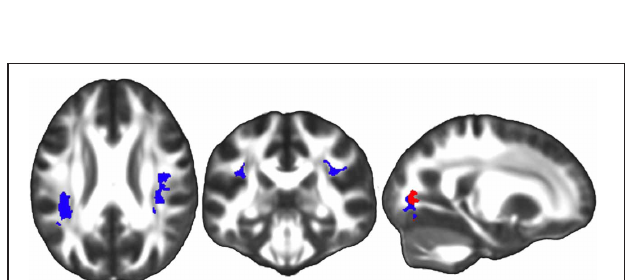
FIGURE 6 | Simple effects analysis within the FA factorial model revealed significant regions in the bilateral SLF in which TBI subjects exhibited greater FA at the third time point compared to the first time point (red), indicating a longitudinal FA increase during the